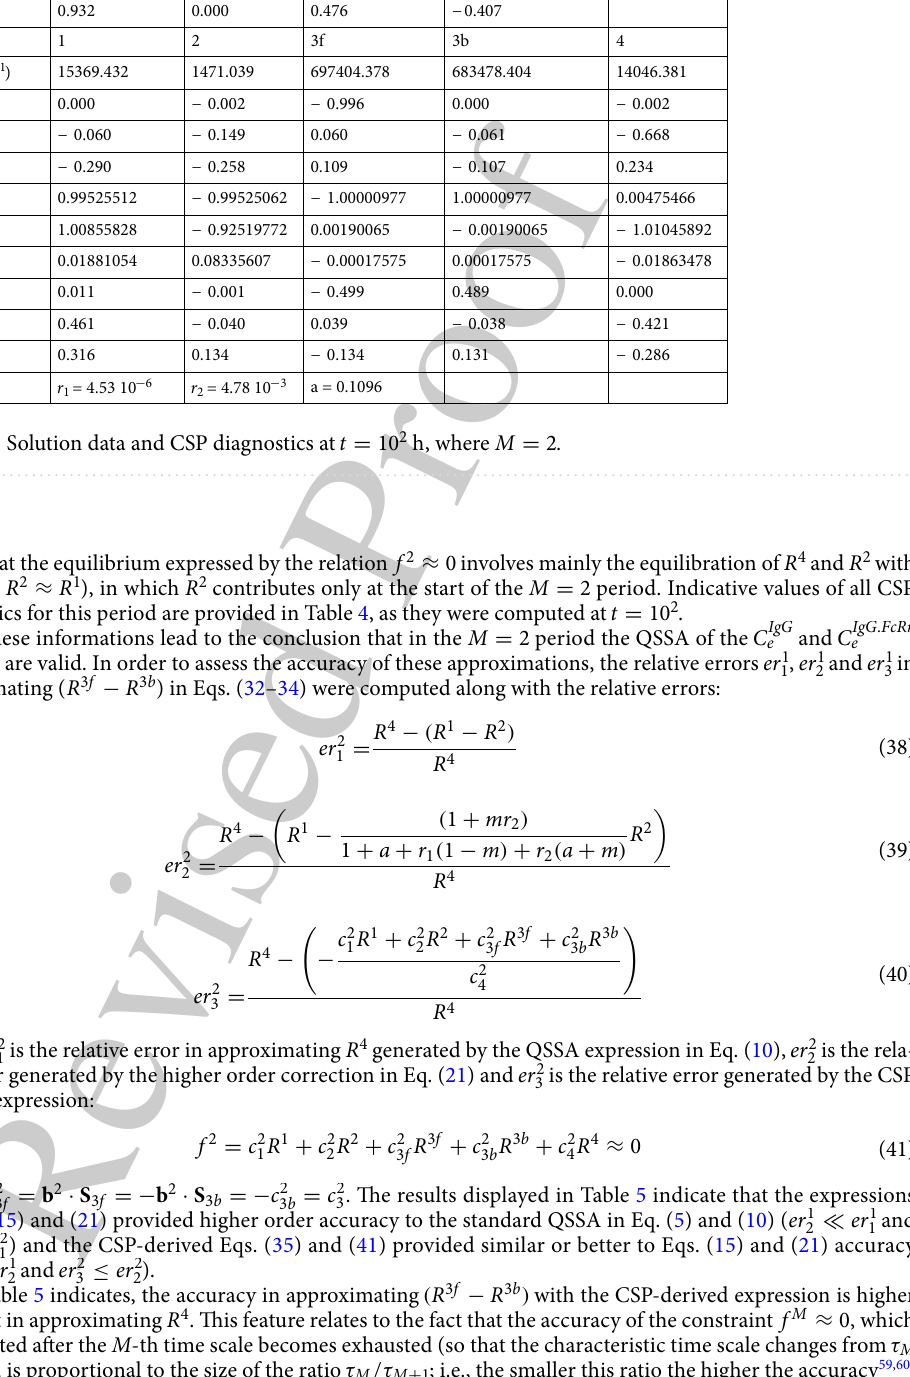
As Table 5 indicates, the accuracy in approximating ( R 3 f − R 3 b ) with the CSP-derived expression is higher than that in approximating R 4 . This feature relates to the fact that the accuracy of the constraint f M ≈ 0 , which is generated after the M -th time scale becomes exhausted (so that the characteristic time scale changes from τ M to τ M + 1 ), is proportional to the size of the ratio τ M /τ M + 1 ; i.e., the smaller this ratio the higher the accuracy 59,60 . Accordingly, the accuracy of the CSP expression for approximating ( R 3 f − R 3 b ) in Eq. (35), which becomes valid after the fastest time scale τ 1 becomes exhausted, is proportional to τ 1 /τ 2 , while the accuracy of the CSP expres- sion for approximating R 4 in Eq. (41), which becomes valid after τ 2 becomes exhausted, is proportional to τ 2 /τ 3 . Figure 4 shows that τ 1 /τ 2 ≪ τ 2 /τ 3 . Therefore, the accuracy of the former approximation will be higher than the